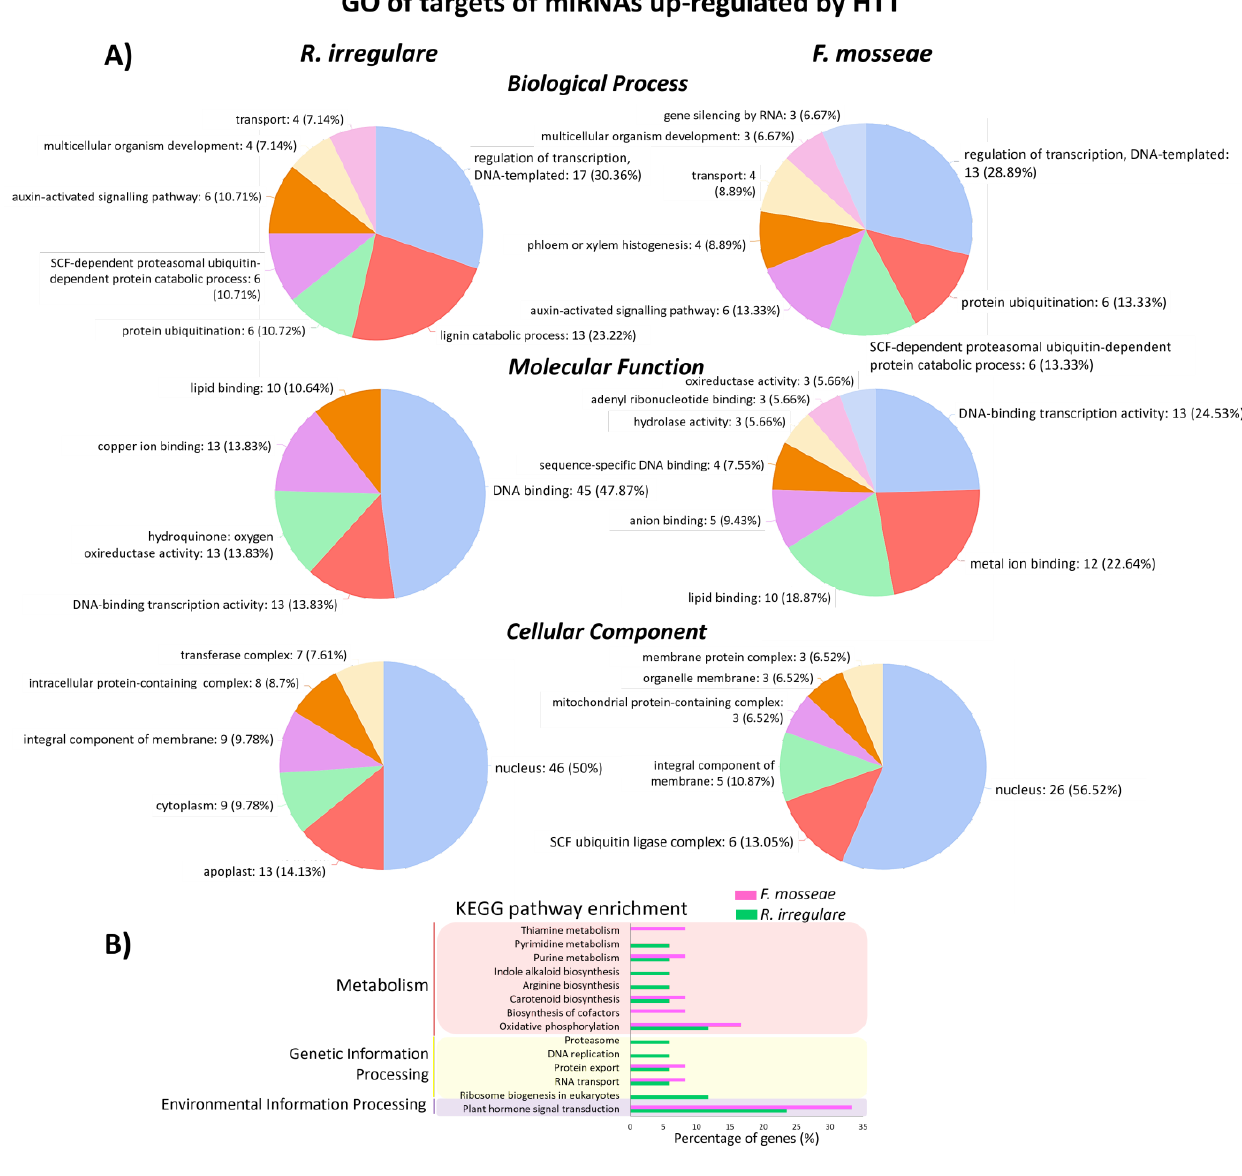
Figure 4. ( A ) Pie-charts demonstrating GO enrichment analysis and ( B ) KEGG pathway enrichment for target genes of miRNAs upregulated by HTT — 40 °C in R. irregulare - and F. mosseae- inoculated grapevine plants. GO terms are shown sorted highest to lowest.